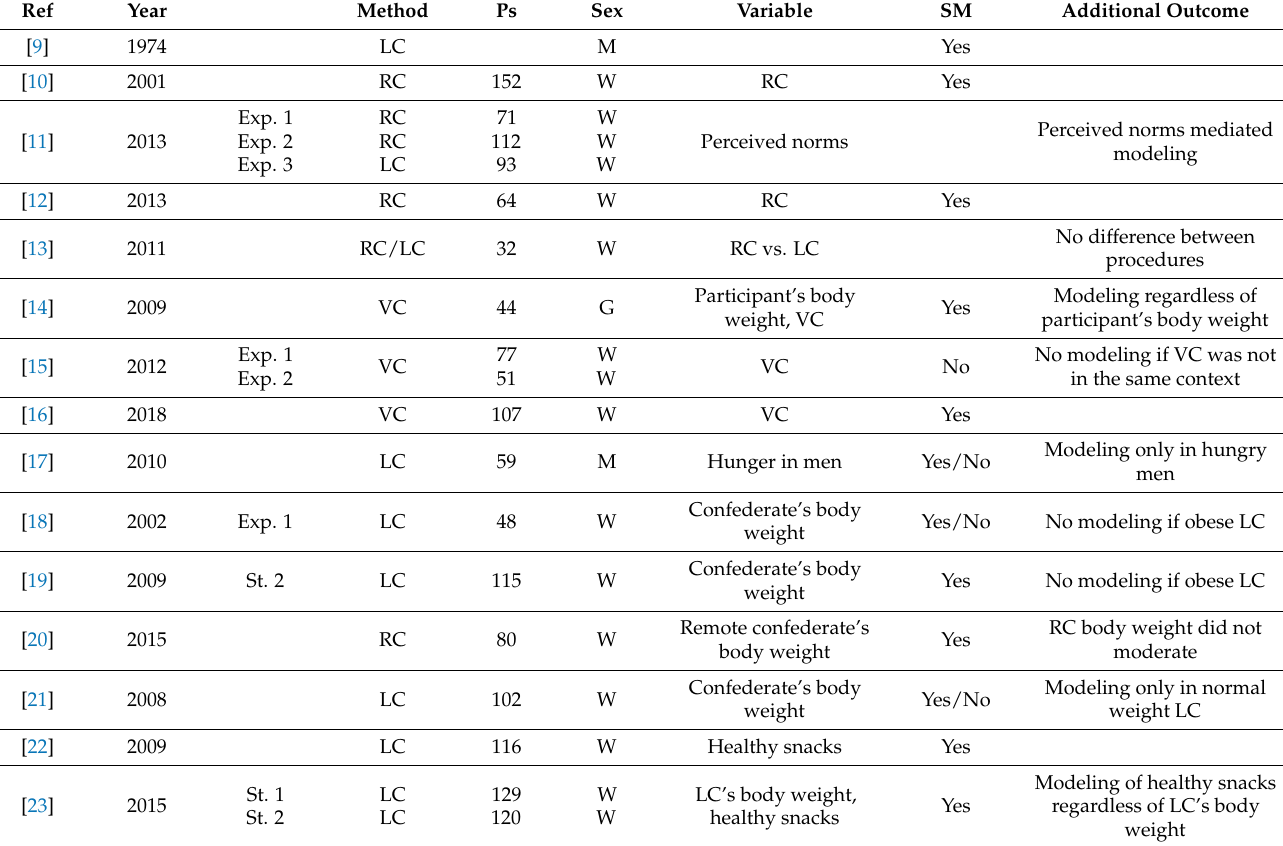
Table 1. Characteristics of described experiments in order of